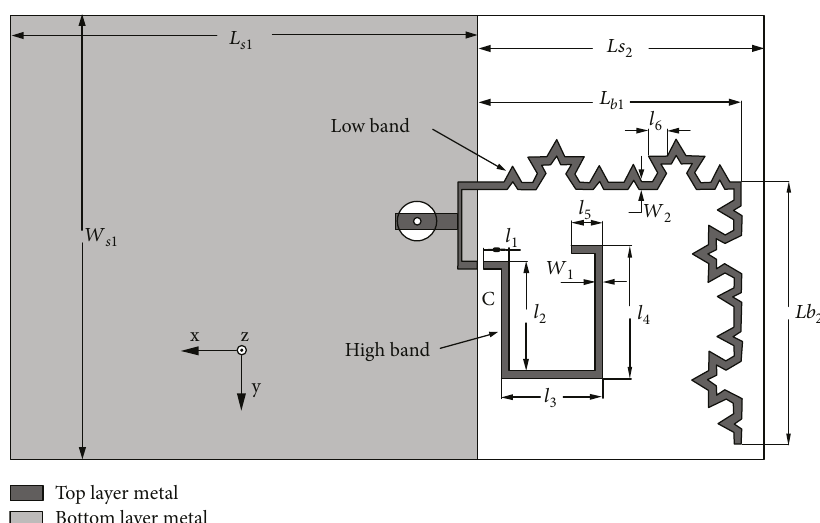
= 1 , w =1, l =3.2, l 1 2 1